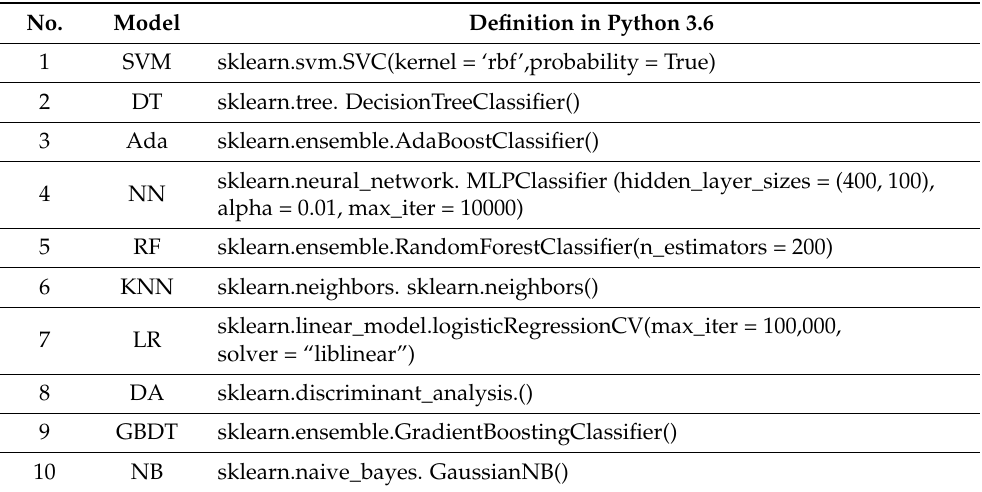
Table 3. Descriptions of the 10 models in this